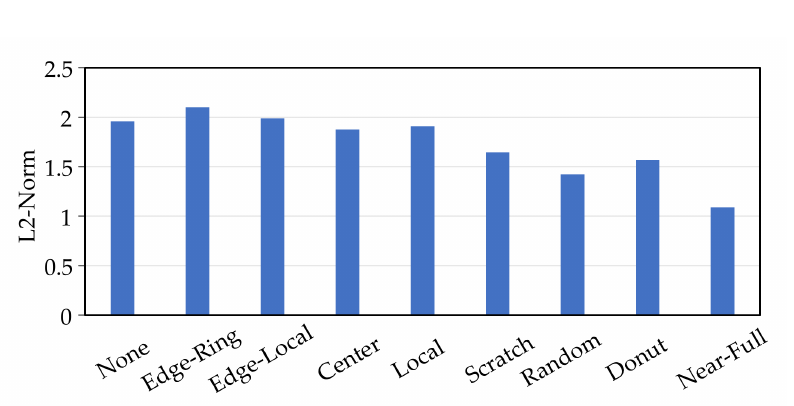
Figure 11. L2-norm of the